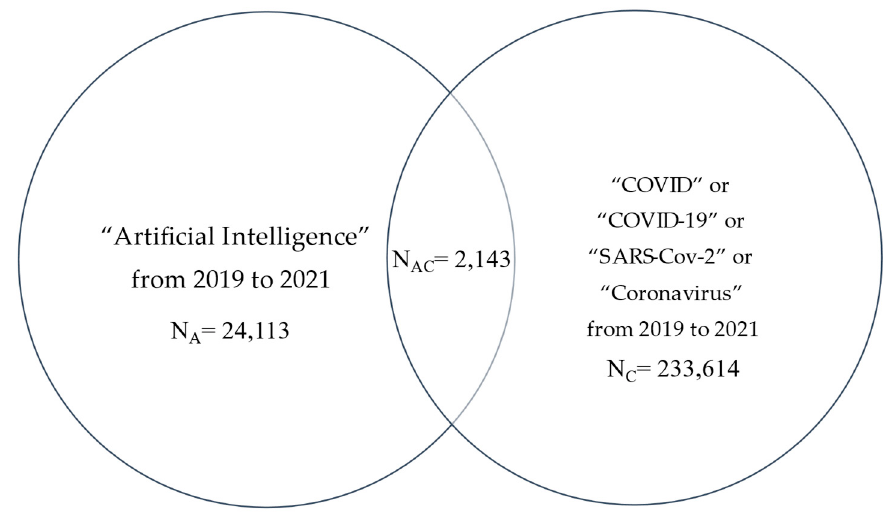
Figure 2. Number of literatures on AI and COVID-19 from 2019 to 2021.